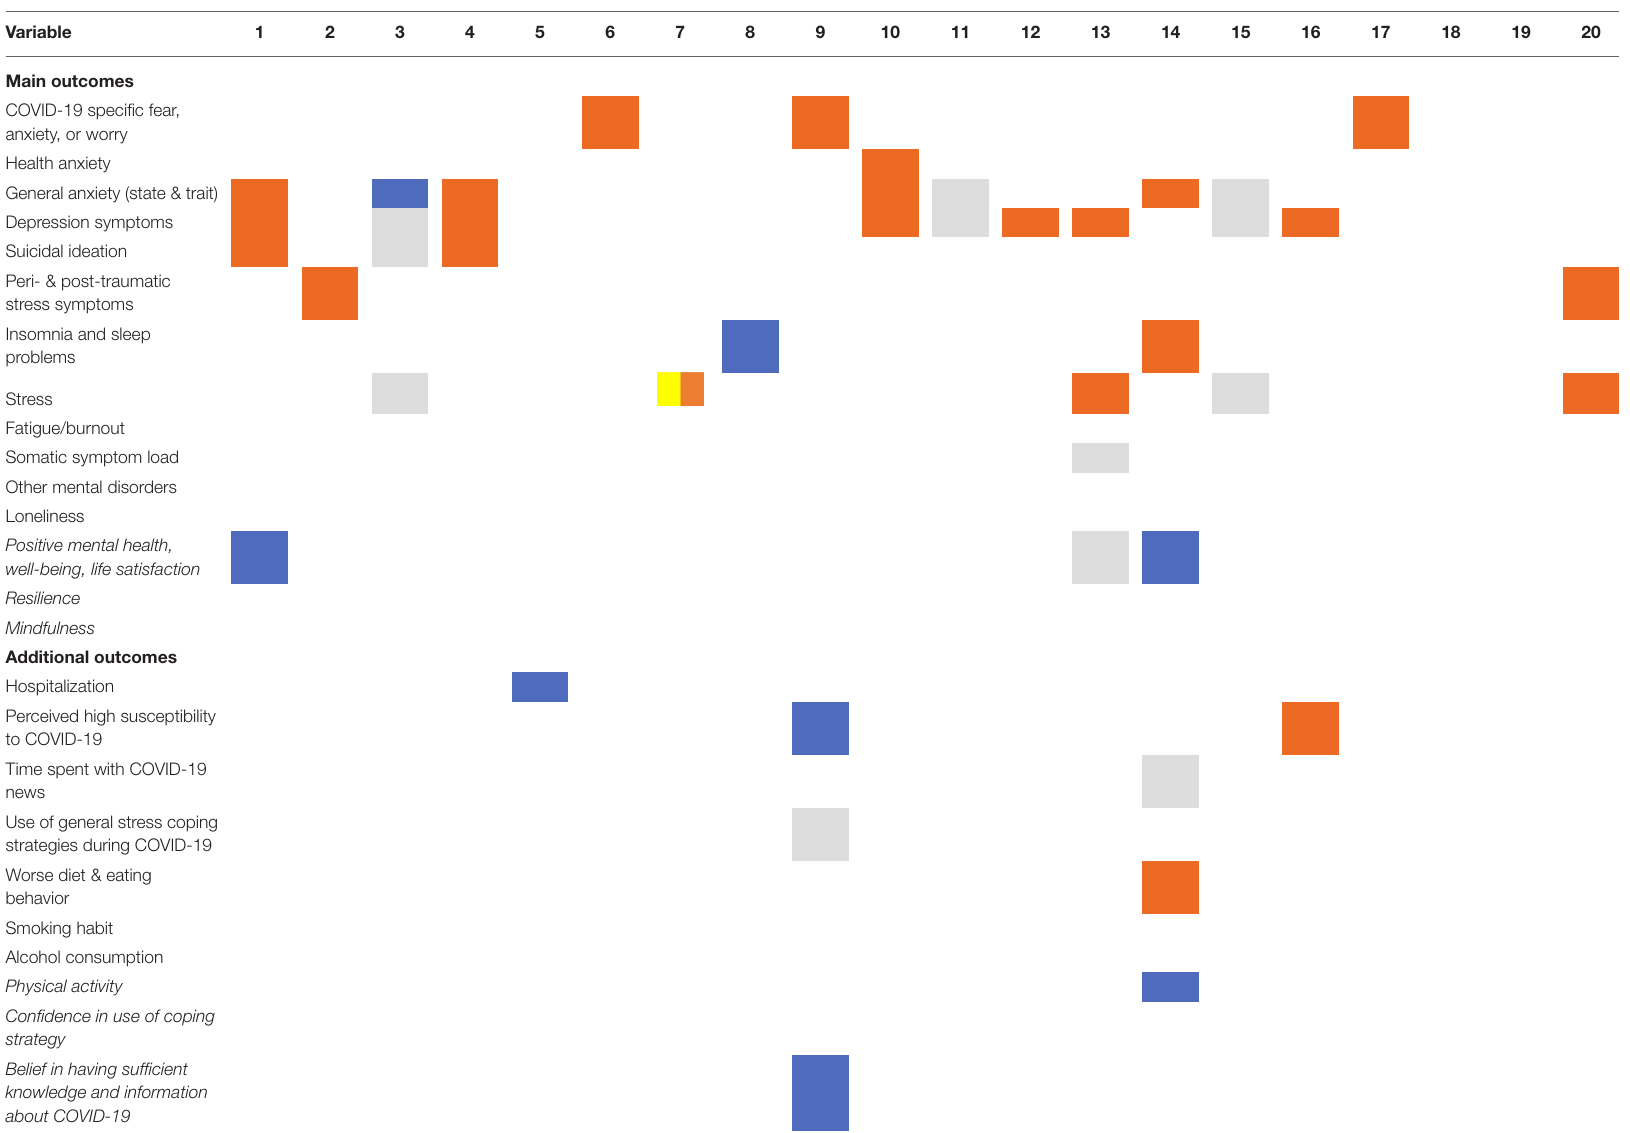
TABLE 2 | Study specific overview of sex- and gender-stratified assessed outcome variables in all studies.